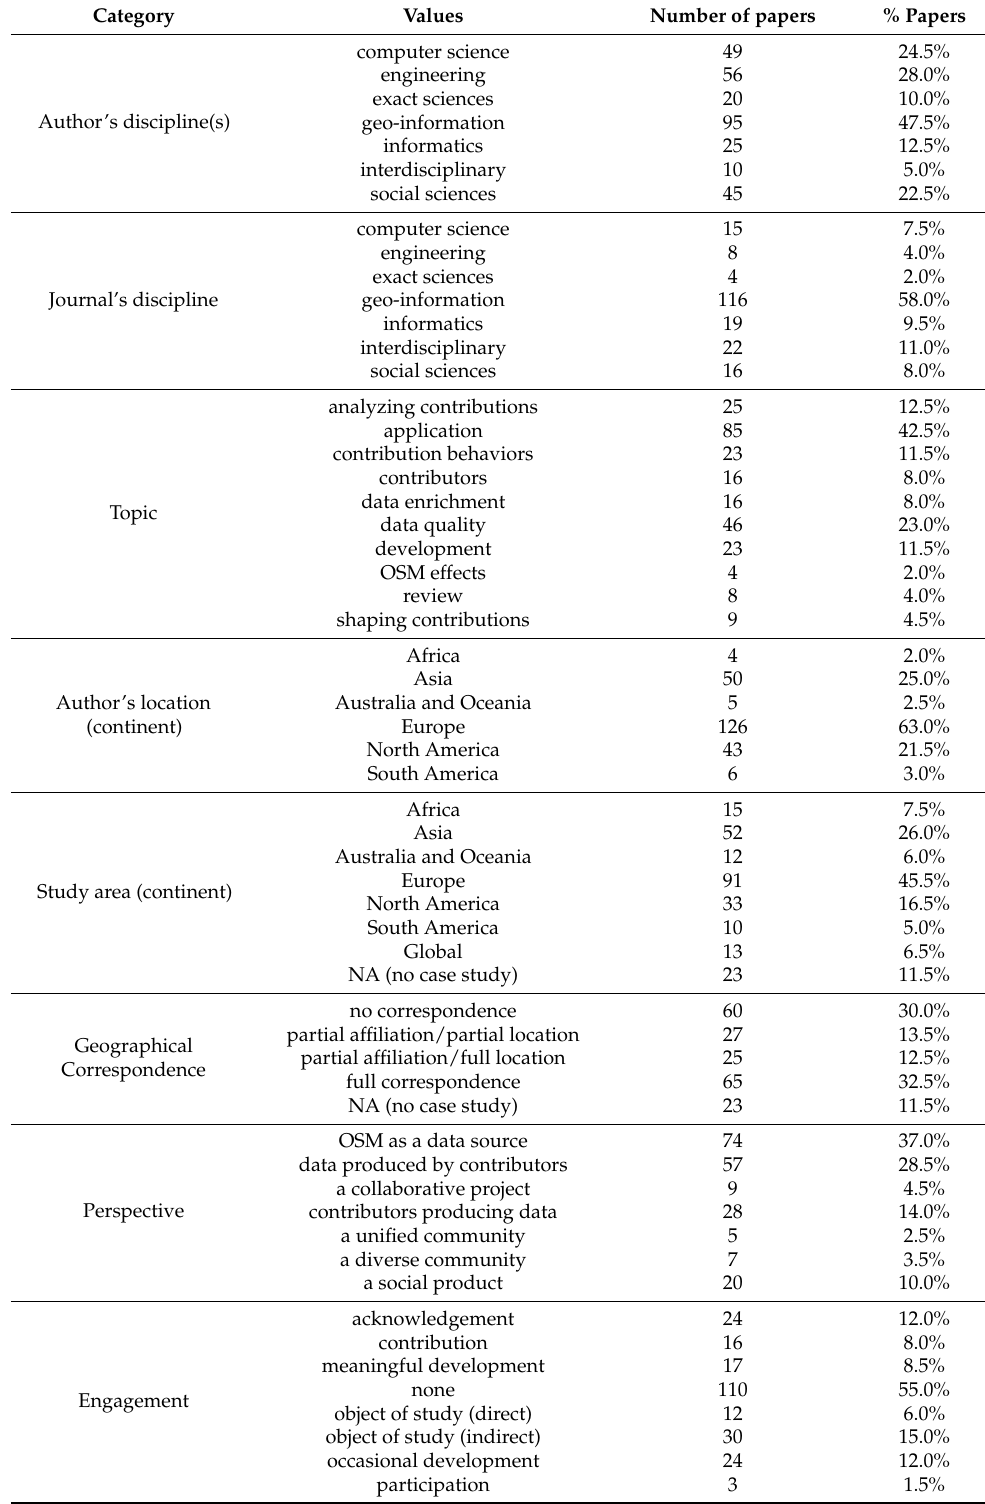
Table 3. Distribution of category values over all